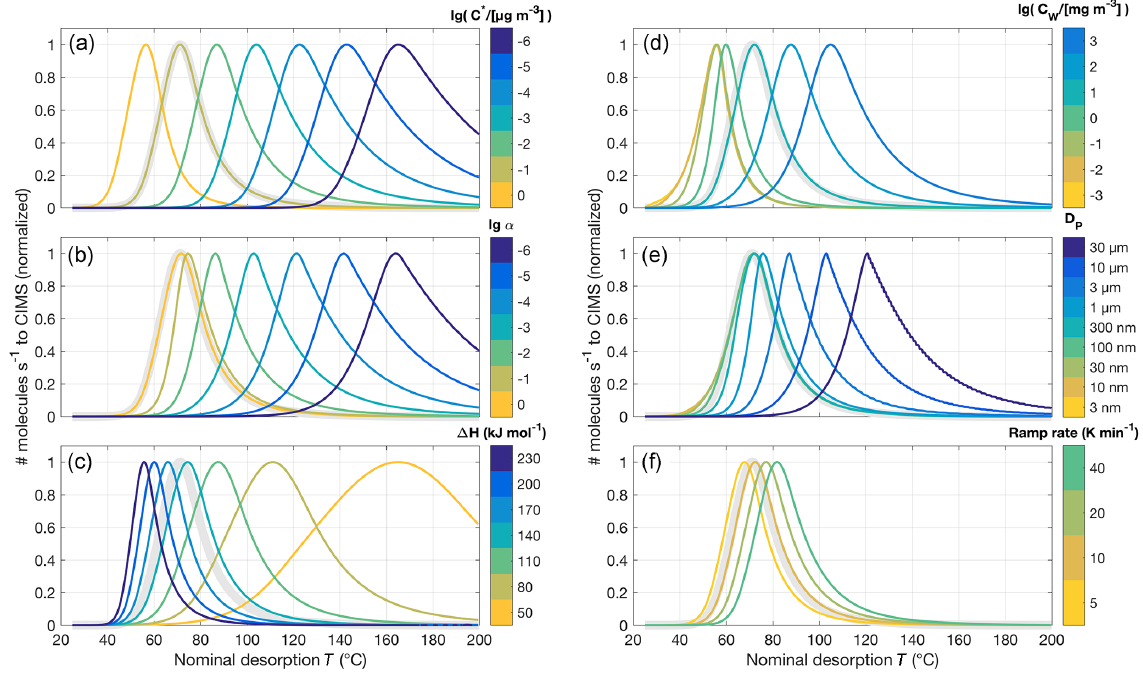
Figure 6. Normalized model thermograms for the simple system of an aerosol particle composed of only one compound, varying a certain = 0 . 1µgm − 3 , α = 1, (cid:49)H = 150kJmol − 1 , τC W = 8 . 77mgm − 3 , D input parameter for each panel. The default parameters are C ∗ 0 150nm, and temperature ramp rate = 0 . 14Ks − 1 ; the corresponding default thermogram is shown in bold light gray in each panel. (a) is the same as Fig. 5c, i.e., varying C ∗ , except that each thermogram is normalized to 1. (b) shows varying the evaporation coefficient from α = 1 0 down to 10 − 6 , (c) the vaporization enthalpy (cid:49)H between 50 and 230kJmol − 1 , (d) the wall “stickiness” C W between 0.1 and 1000mgm − 3 , and (e) the initial particle diameter D P , 0 . (f) shows the effect of adjusting the temperature ramp